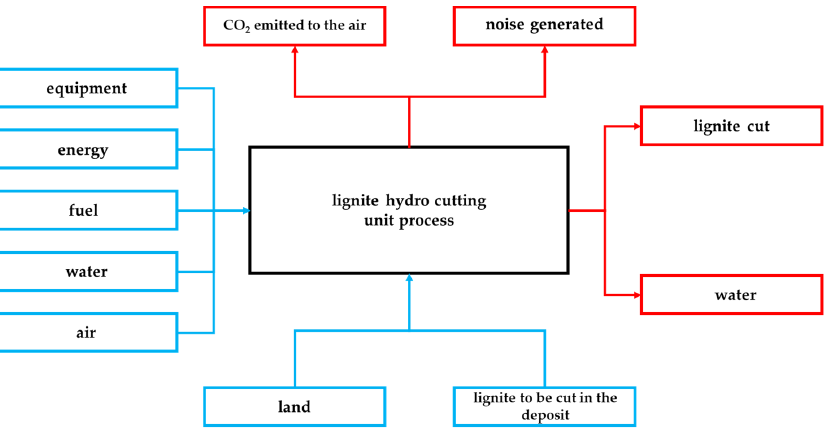
Figure 4. Details of the lignite hydro-cutting unit process (blue boxes—inputs, red boxes—outputs).